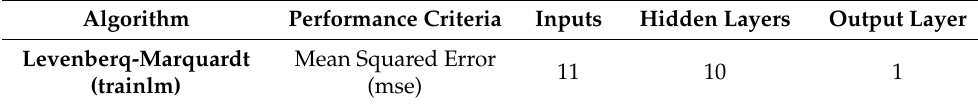
Table 4. Parameters of artificial neural network (ANN) model.